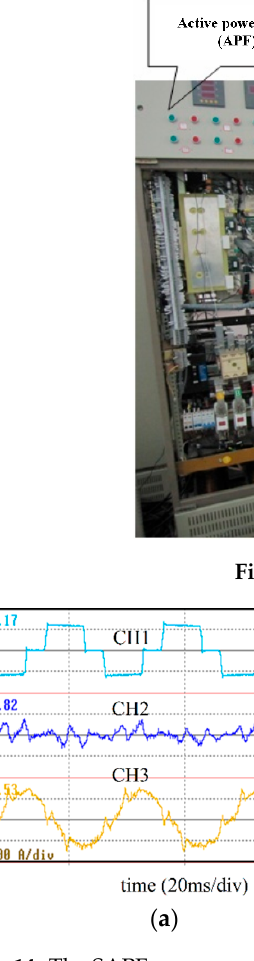
Figure 14. The SAPF compensation performance with frequency deviation: ( a ) effect using the RDFT method, and ( b ) effect using the DMRDFT method. (CH1 — Load current of A phase; CH2 — SAPF current of B phase; CH3 — Grid current of C phase) Table 2. The measurement result of harmonic current.